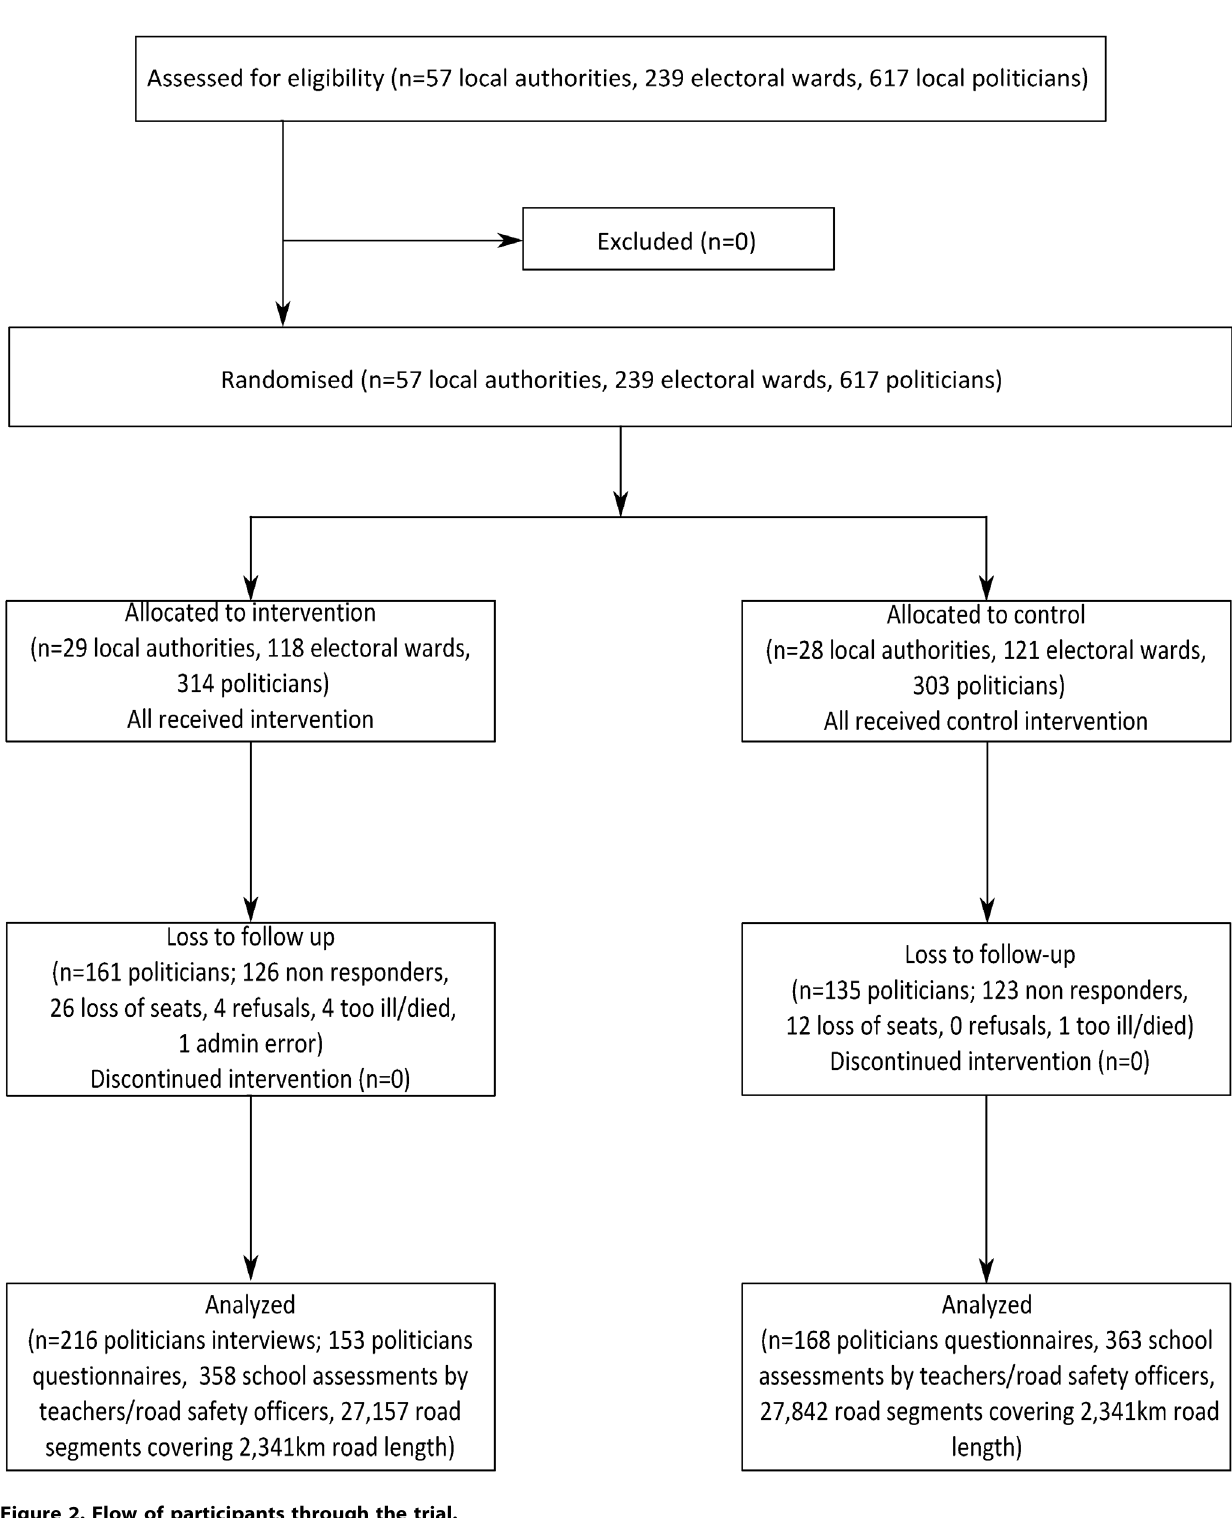
Figure 2. Flow of participants through the trial.